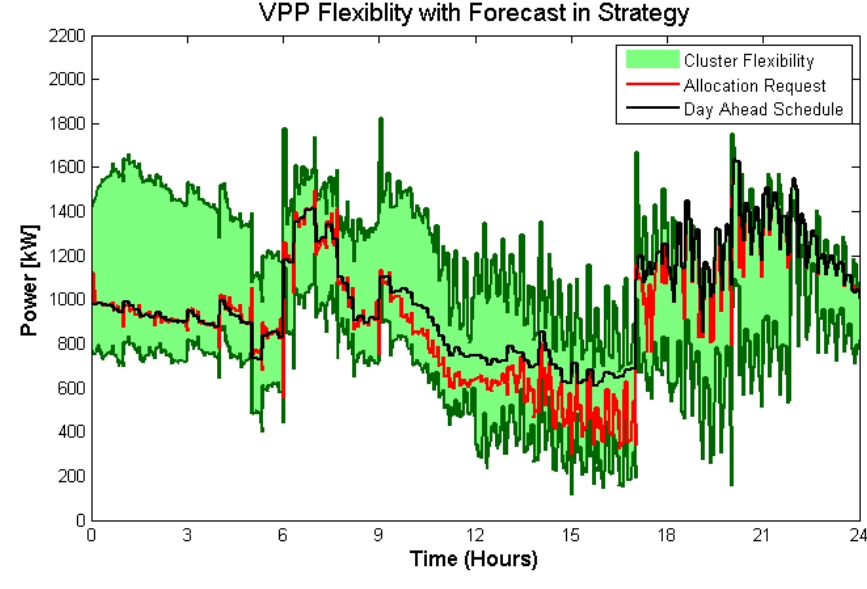
Figure 12. Flexibility degradation with machine learning.